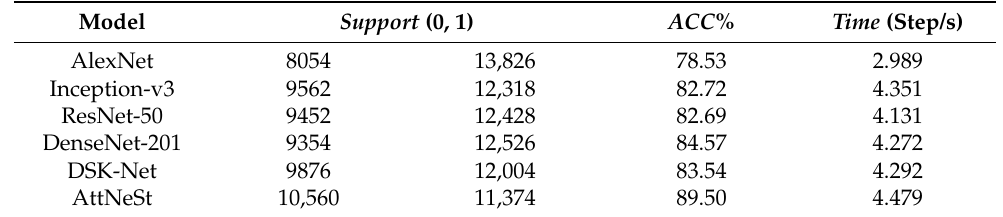
Table 6. Results of comparison